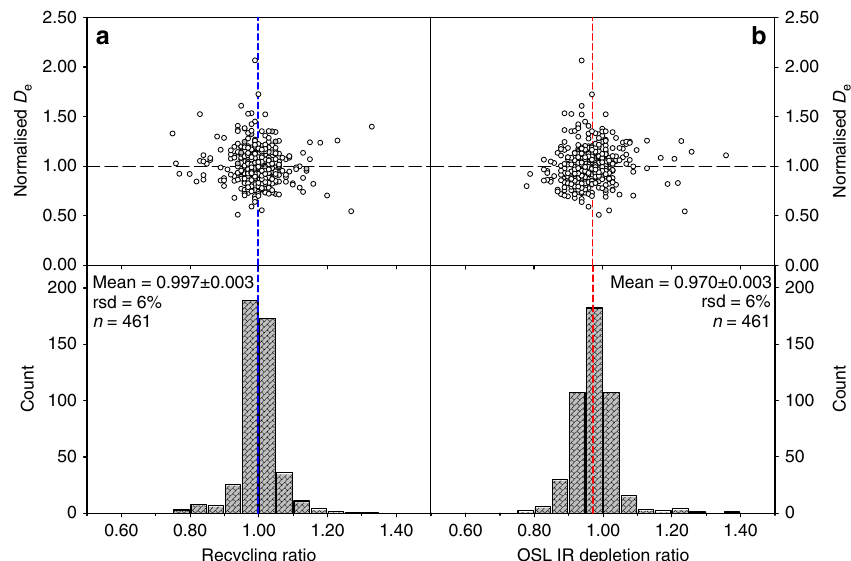
Fig. 6 Effect of recycling ratio and OSL IR depletion ratio on quartz OSL D e . Samples D38101 to − 54 are from section D and at least six aliquots were measured per sample. Bottom graphs show the recycling and OSL IR depletion ratios as a histogram with mean recycling and OSL IR depletion ratios plotted as blue and red dashed lines, respectively. Top graphs show, for the same aliquots, the normalised D e (to mean sample D e given in Supplementary Data 1) plotted as a function of recycling ratio ( a ) or OSL IR depletion ratio ( b ). Black dashed lines at unity serve as an eye